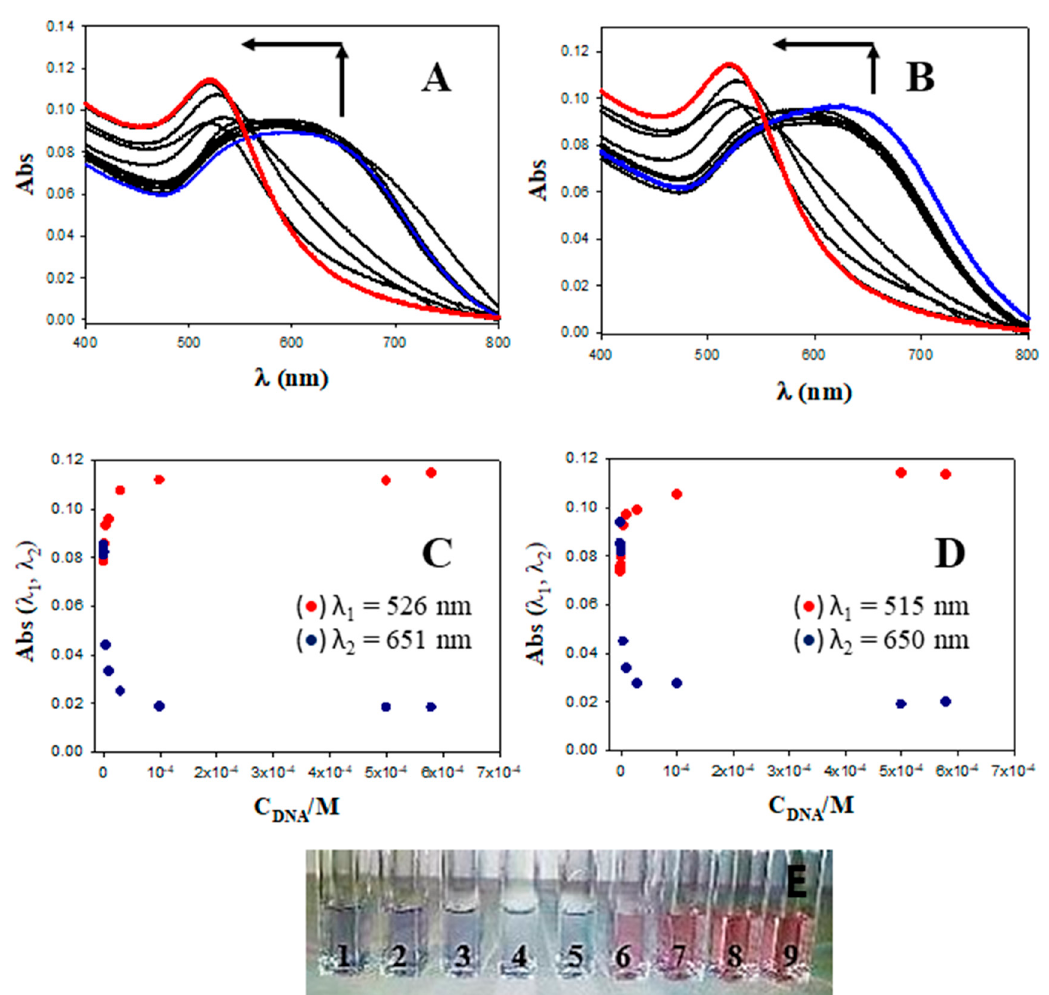
Figure 5. Absorbance titration of aggregated Au@16-s-16/SDS nanosystems at different C DNA concentrations (addition method B). ( A , B ) C DNA = 0 µ M (blue spectrum), C DNA = 580 µ M (red spectrum), C DNA = 0.050, 0.10, 0.50, 0.75, 1.00, 5.00, 10.0, 30.0, 100.0, and 500.0 µ M (black spectrum, arrow direction). ( C , D ) Absorbance versus C DNA , red (nonaggregated nanoparticles) and blue points (aggregated nanoparticles) correspond to absorbance data at fixed wavelength. ( A , C ) Au@16-3- 16/SDS/DNA system and ( B , D ) Au@16-6-16/SDS/DNA system. ( E ) Detailed view of corresponding color changes for Au@16-3-16/SDS/DNA system. (1) C DNA = 0 µ M, (2) C DNA = 0.050, (3) C DNA = 0.10, (4) C DNA = 0.50, (5) C DNA = 1.0 µ M, (6) C DNA = 10.0 µ M, (7) C DNA = 30.0 µ M, (8) C DNA = 100.0 µ M, and (9) C DNA = 580.0 µ